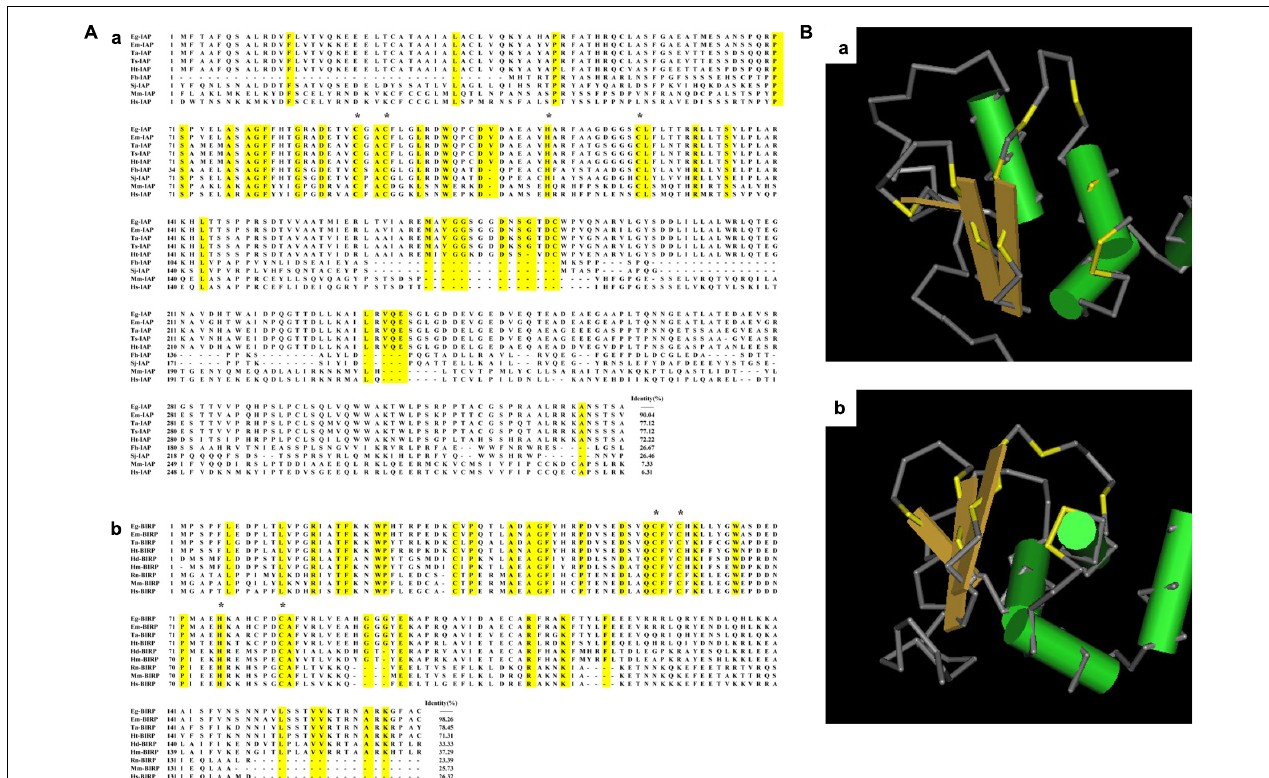
FIGURE 1 | Bioinformatic analysis of Eg-IAP and Eg-BIRP. (A) Sequence alignment analysis of Eg-IAP and Eg-BIRP sharing homology with other species. (a) The following sequences of IAP were retrieved from the GenBank: Eg, Echinococcus granulosus (Genbank: CDS22977.1); Em, Echinococcus multilocularis